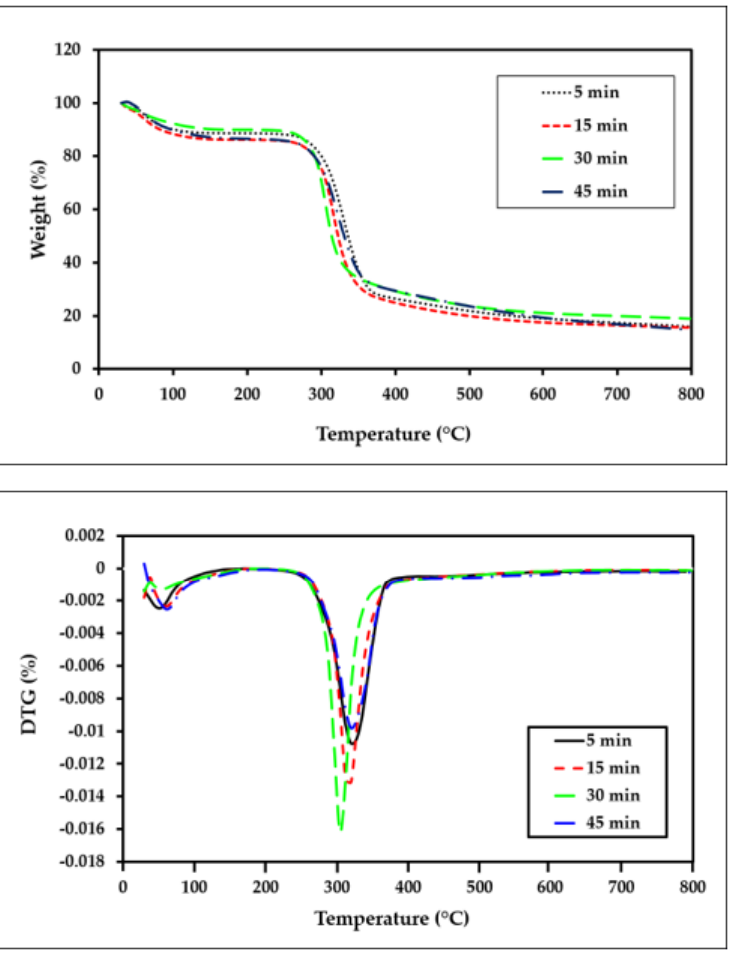
Figure 9. TGA − DTG curves of all-cellulose composites after 5, 15, 30, and 45 min of dissolution.